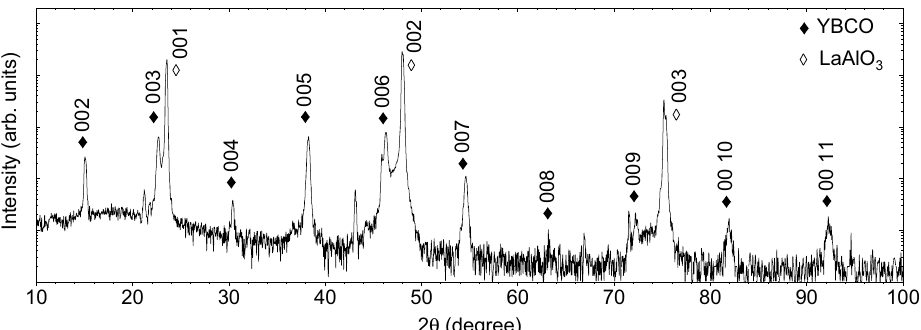
Figure 2. θ − 2 θ XRD scan of YBCO film grown on LAO [0 0 1]